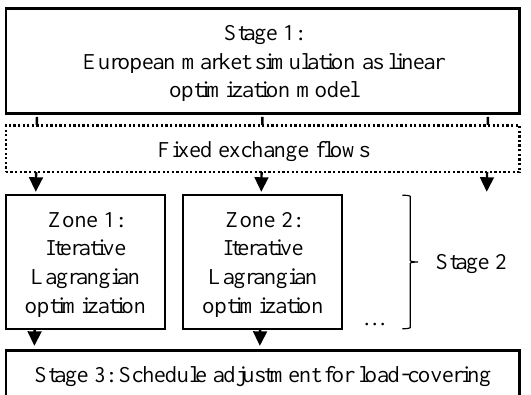
Figure 1. Flow chart for the multi-stage approach [23].